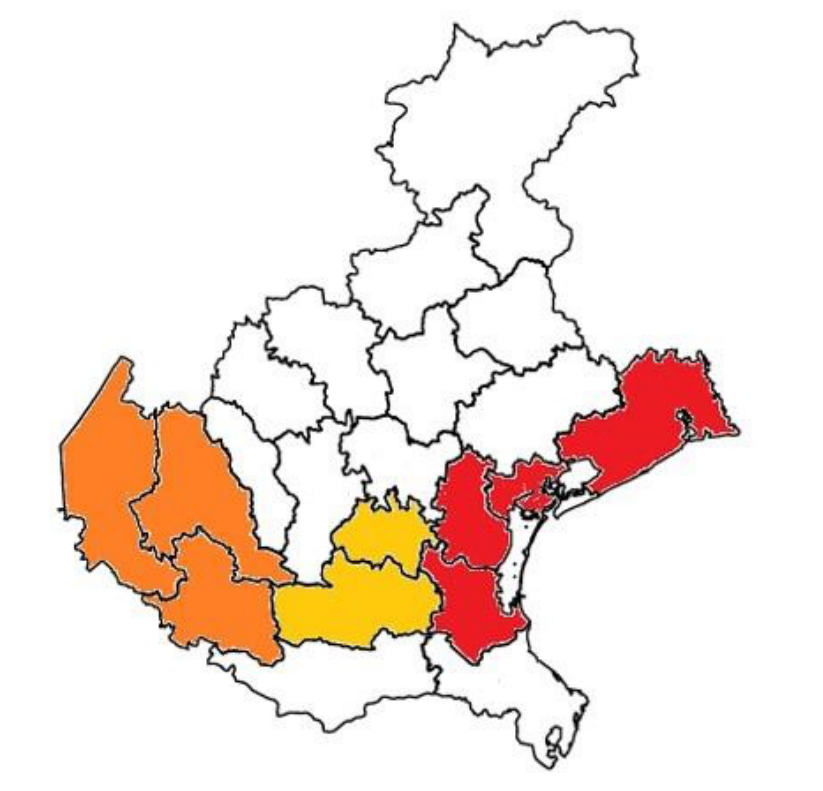
Figure 2. Map of the Veneto region showing the areas with the highest incidence of Takotsubo syndrome during the first and second pandemic waves. Table 2. Baseline characteristics, clinical presentation, and